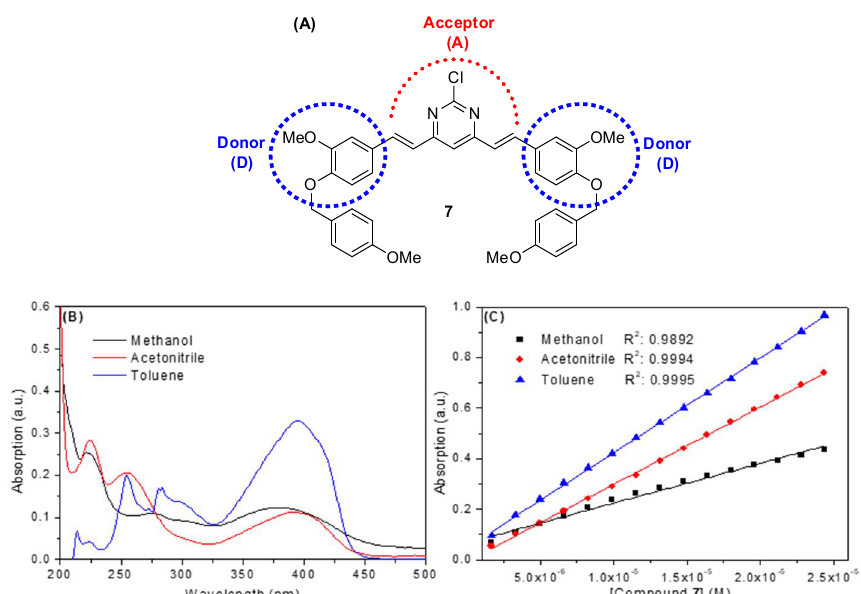
Figure 2. ( A ) Chemical structure of the compound 7 highlighting the D-A-D moieties. ( B ) UV-visible spectra for the compound 7 in methanol, acetonitrile and toluene. [ 7 ] = 2.32 × 10 − 6 mol/L ( C ) Beer- Lambert plots for the determination of ε value for 7 in three different solvents (at λ max = 380, 390 and 395 for methanol, acetonitrile and toluene, respectively). [ 7 ] = 0.17–2.44 × 10 − 5 mol/L.